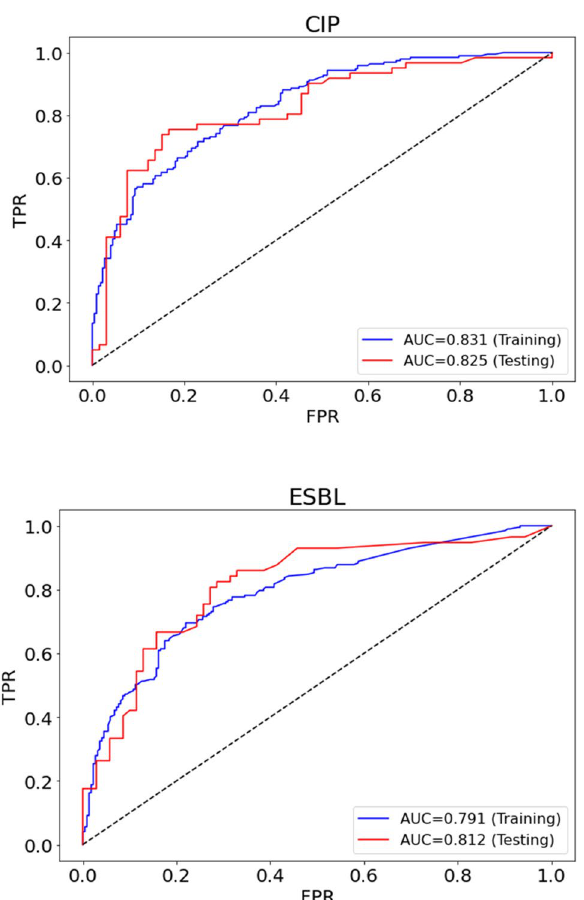
Figure 3. Overall performance of the Gradient-Boosted Decision Tree (GBDT) model. The area under the receiver operating characteristic curve (AUC) of training and testing sets in predicting resistance to ciprofloxacin (CIP) and the production of extended-spectrum β-lactamase ( ESBL) of the uropathogen was shown. TPR is True Positive Rate, and FPR is False Positive